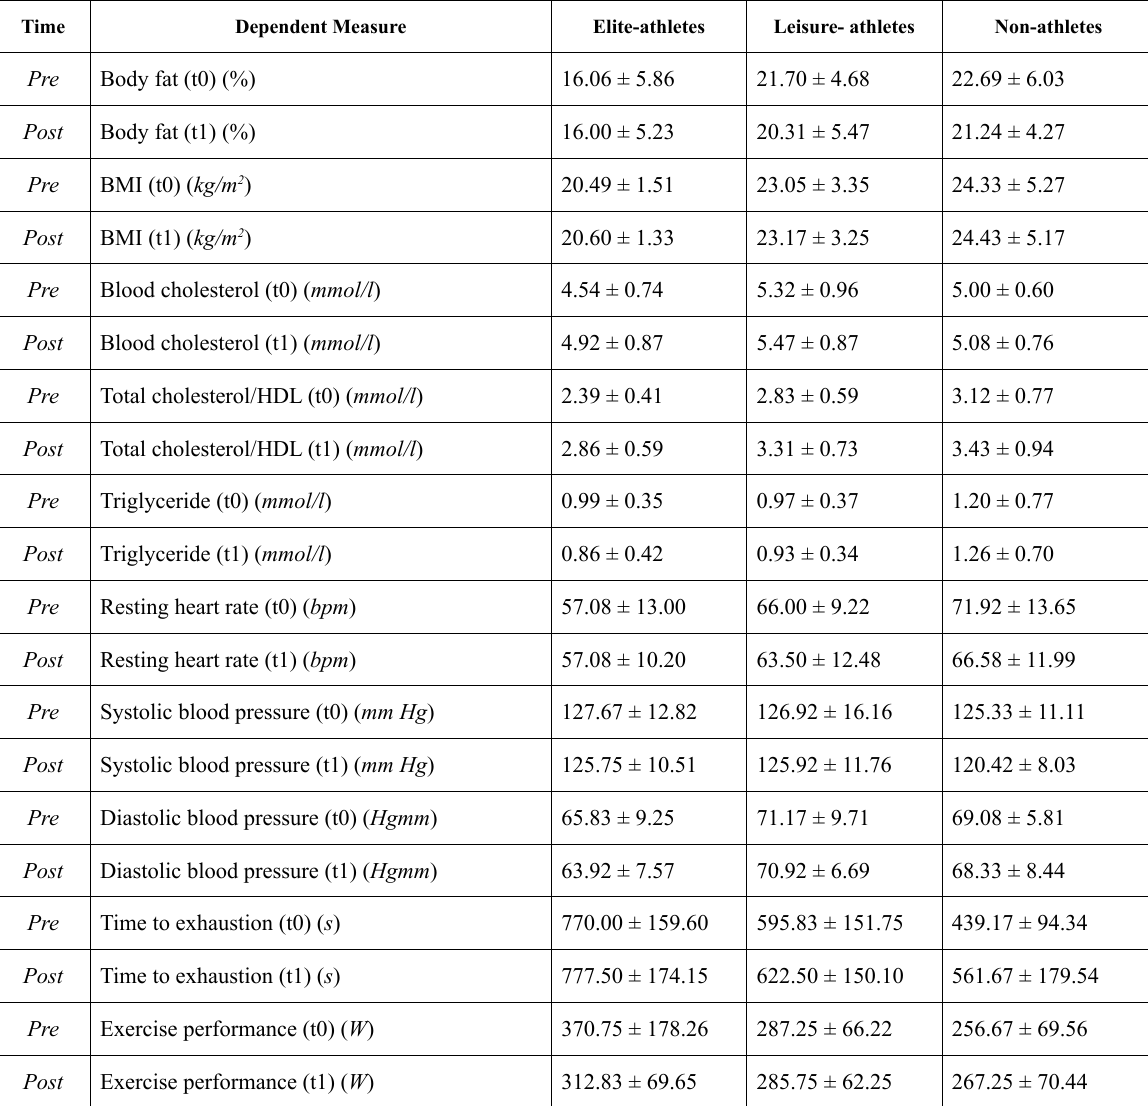
Table. Changes in the dependent measures over 90 days in three